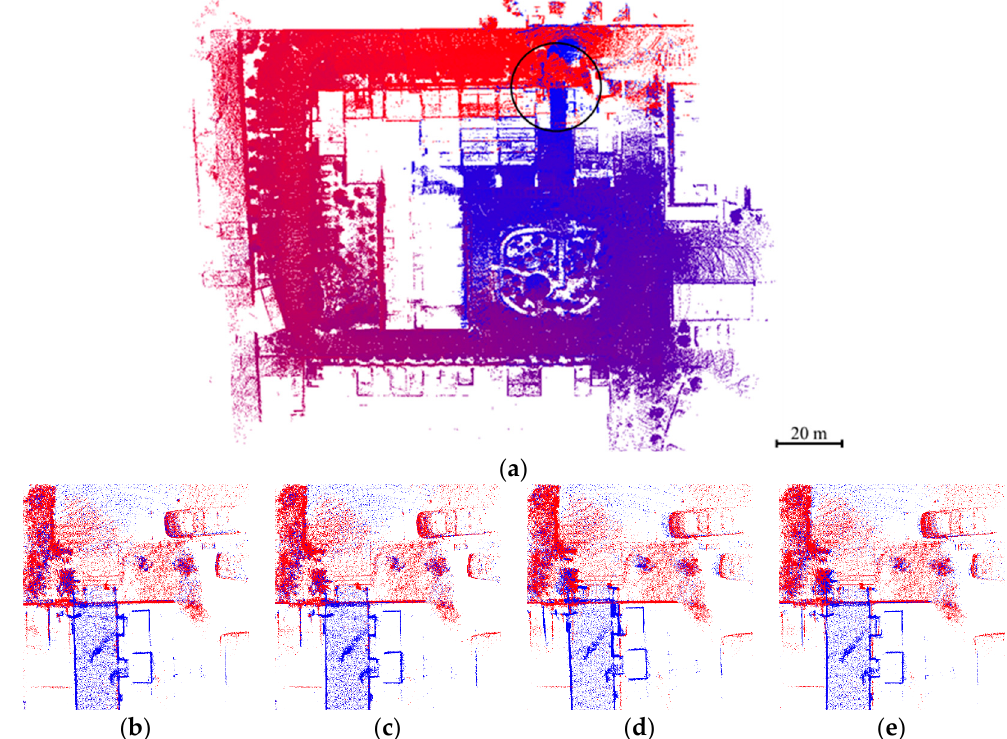
Figure 11. Comparison between the point clouds before and after optimization in dataset 3. ( a ) The top view of the point cloud after optimization; ( b ) enlarged view of the raw output point cloud of Cartographer; ( c ) enlarged view of the optimized point cloud of Cartographer; ( d ) enlarged view of the raw output point cloud of LOAM; ( e ) enlarged view of the optimized point cloud of LOAM.